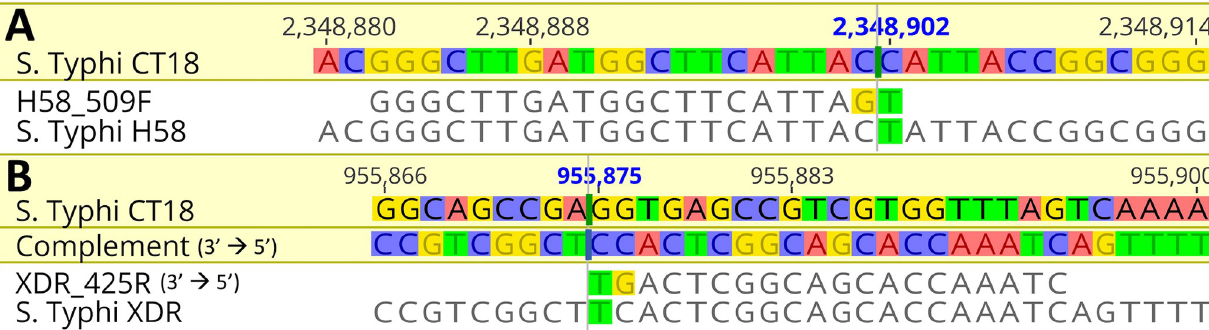
Fig 3. Gel image showing the results of our multiplex PCR assay on a range of non-Typhi Salmonella and non- Salmonella DNA samples. Results show no positive reaction with non-Typhi serotypes or non- Salmonella samples, with all expected amplicon bands present in the target samples. Lane M, 1 kb DNA ladder; lane 1, S . Typhi BRD948; lane 2, S . Typhi SGB87; lane 3 S . Typhi Quail strain; lane 4, S . Typhi lupe GEN0059; lane 5, S . Typhi 403 Ty; lane 6, S . Paratyphi A; lane 7, S . Paratyphi B; lane 8, S . Typhi H58 12148; lane 9, S . Typhi H58 12960; lanes 10–14, S . Typhi XDR1-5; lane 15, S . Enteritidis; lane 16, S . Hadar; lane 17, S . Infantis; lane 18, S . Cholerasuis; lane 19, S . enterica subsp. arizonae; lane 20, S . enterica subsp. diarizonae; lane 21, S . Dublin; lane 22, S . Newport; lane 23, S . 1,4, (5),12:i; lane 24, S . Kentucky; lane 25, S . Heidelberg; lane 26, S . Javiana; lane 27, S . Saint Paul; lane 28, S . Pullorum; lane 29, S . Typhimurium D23580; lane 30, S . Typhimurium 4/74; lane 31, E . coli BL21; lane 32, V . cholerae O1 El Tor; lane 33, no template control (NTC); lane X, not